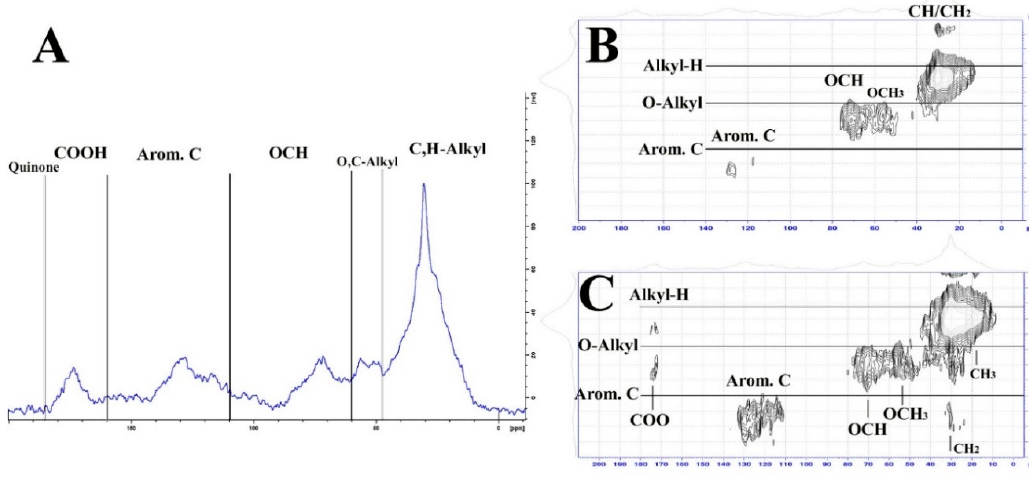
Figure 4. 1 H- 13 C (HETCOR) and 13 C (CP / MAS) NMR spectra of HAs isolated from soils of King-George isl., Antarctica. ( A ) 13 C (CP / MAS) NMR; ( B ) 1 H- 13 C (HETCOR) NMR with contact time 0.2 ms; and ( C ) 1 H- 13 C (HETCOR) NMR with contact time 0.75 ms.